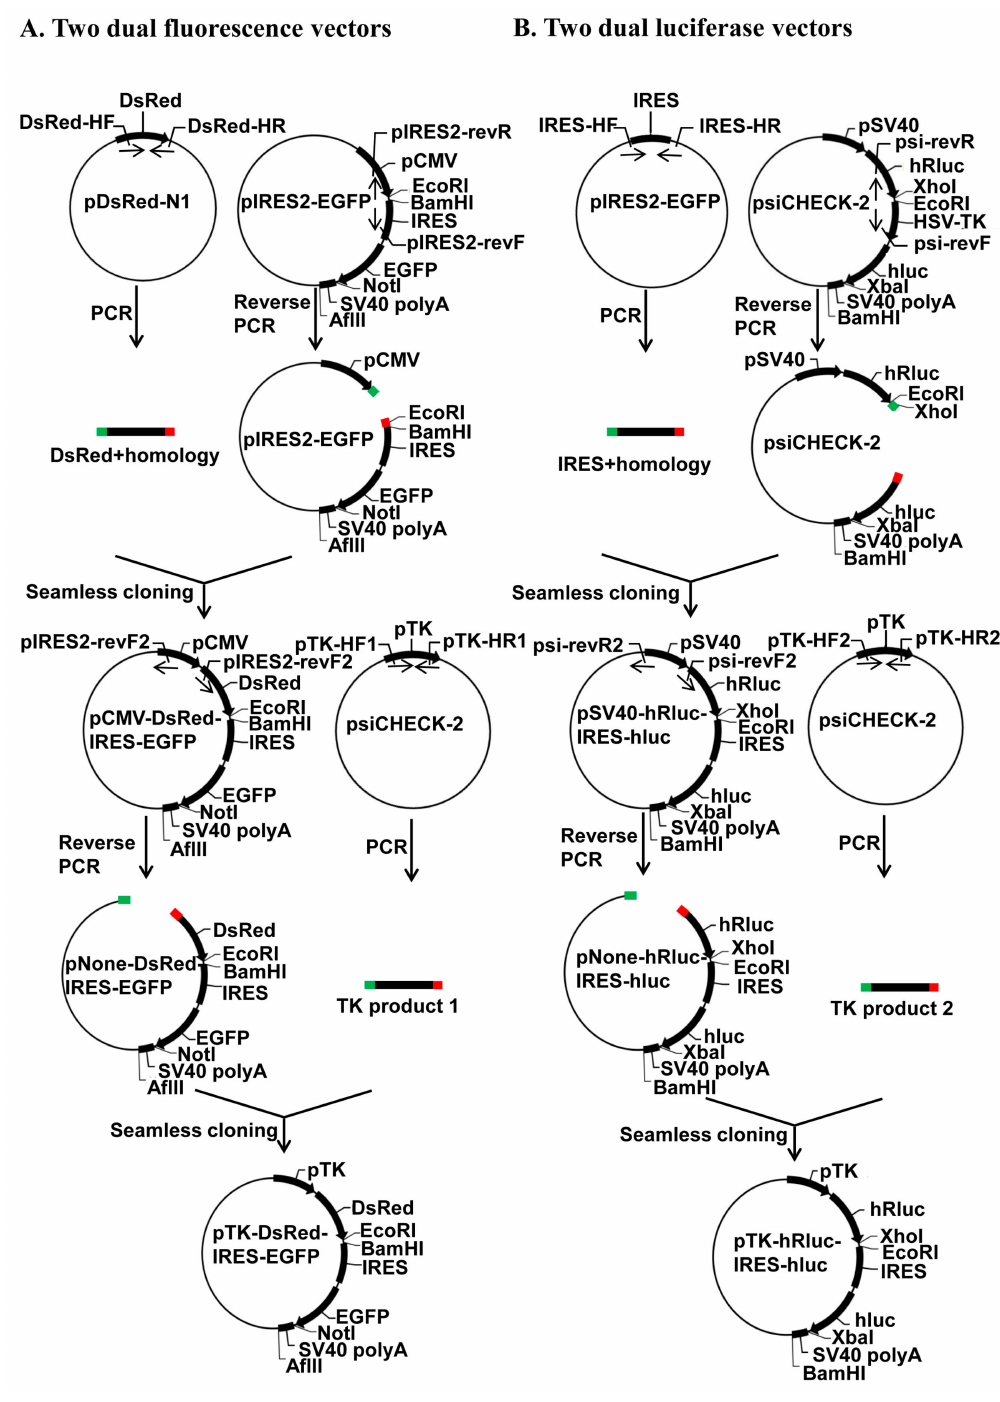
Figure 1. Schematic diagram for construction of the bicistronic reporter system. ( A ) Construction of 2 dual fluorescence reporter vectors pCMV-DsRed-MCS-IRES-EGFP-SV40 pA (for use in mammalian cells) and pTK-DsRed-MCS-IRES-EGFP-SV40 pA (for use in insect cells); ( B ) Construction of 2 dual luciferase reporter vectors pSV40-hRluc-MCS-IRES-hluc-SV40 pA (for use in mammalian cells) and pTK-hRluc-MCS-IRES-hluc-SV40 pA (for use in insect cells). pCMV = CMV promoter, pTK = HSV-TK promoter, pSV40 = SV40 promoter, SV40 pA = SV40 polyadenylation site sequence (Poly(A)), DsRed = Discosoma sp. Red Fluorescent Protein, EGFP = Enhanced Green Fluorescent Protein, hluc = humanized firefly luciferase, hRluc = humanized renilla luciferase, IRES = Internal Ribosome Entry Site. The terminal 15–20 bp homology sequences shared between an insert and the corresponding linearized plasmid are essential for seamless cloning, and thus are colored in red and green,